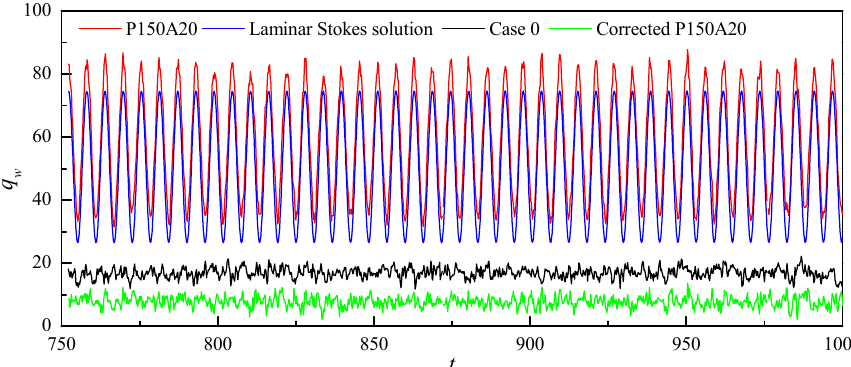
Figure 7. Temporal evolutions of wall heat flux. Data from DNS are spanwise averaged results.